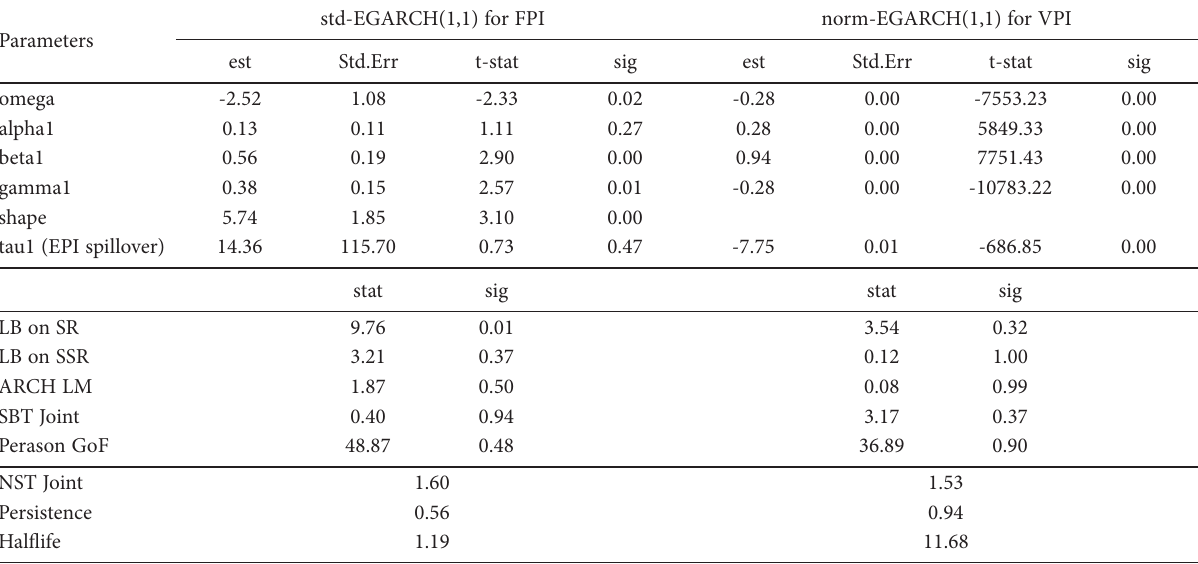
Table 4. The Parameter Estimation of EGARCH(1,1) Models for Spillover from EPI to FPI and VPI with Diagnostics Tests.